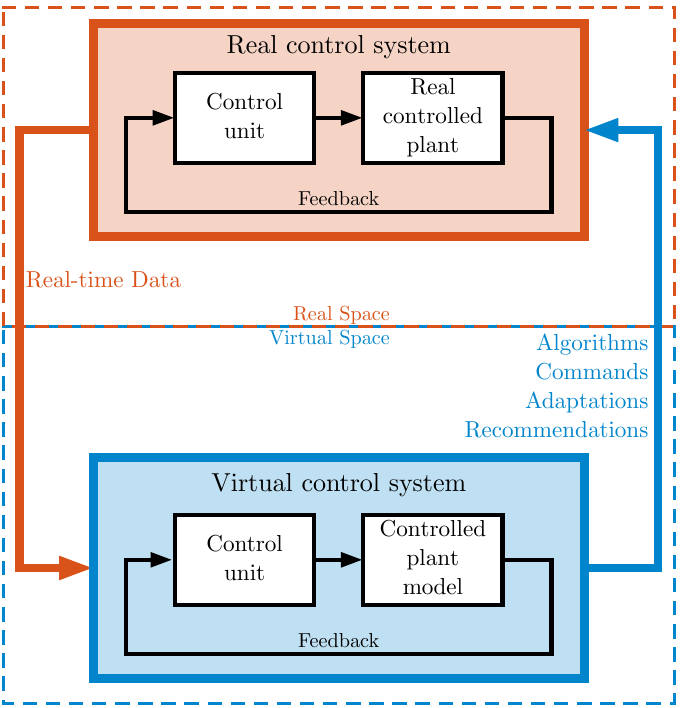
Figure 13. Digital twin containing a real dynamical plant with real feedback controller and virtual dynamical plant with a real feedback controller closed by the feedback of information flows: real-time data and algorithms, commands, adaptations, and recommendations.